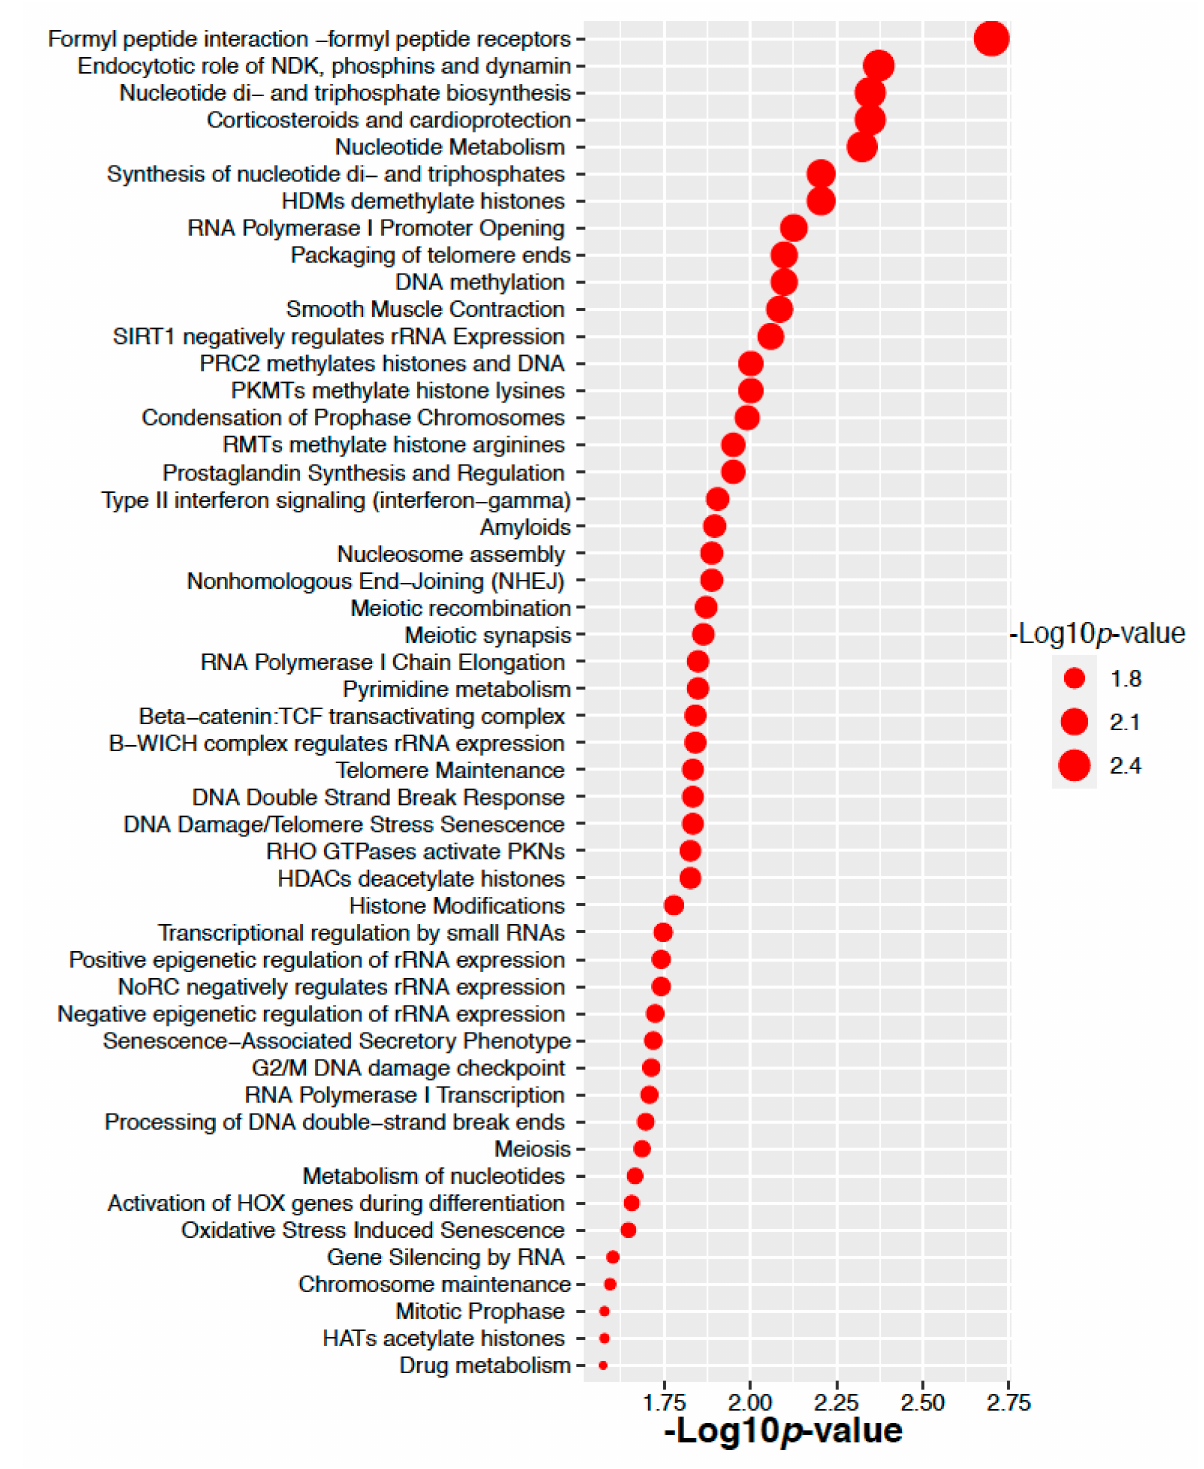
Figure 8. Pathway enrichment of the genes corresponding to the altered 3 proteins in colorectal